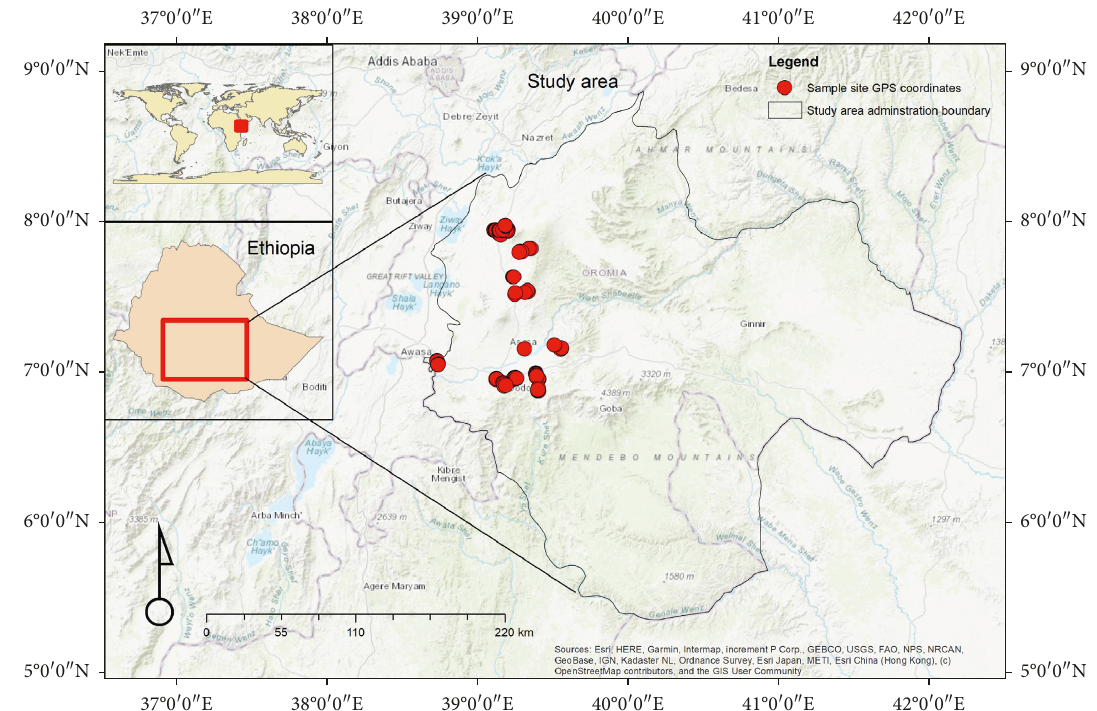
Figure 1: Map of the study sites (research location includes six districts: Kofele, Dodola, and Adaba from the east Arsi zone and Tijo, Sajure, and Bekoji from the west Arsi zone, which are distributed along the Arsi-Bale Massifs in southeastern